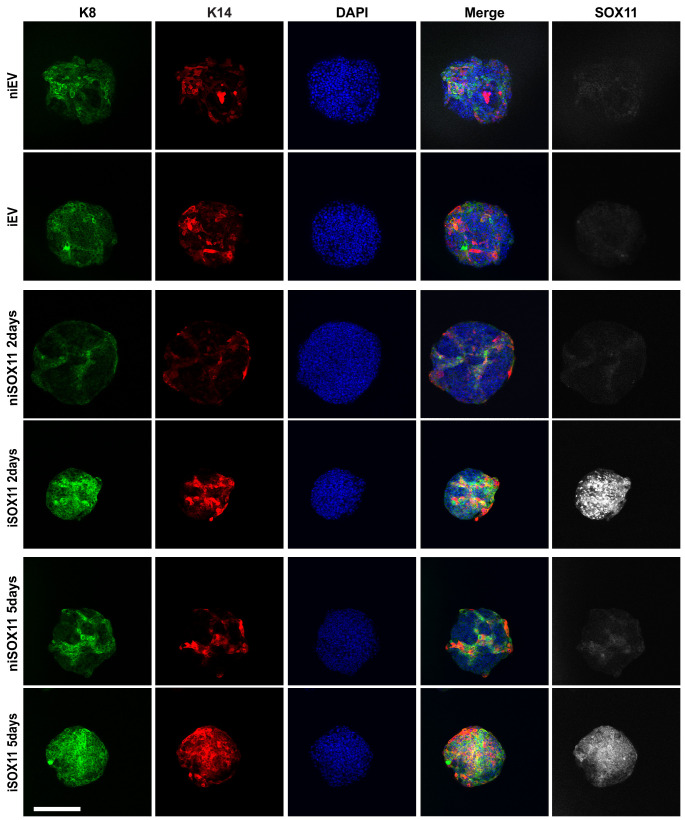
Inducible expression of SOX11 in DCIS.com spheroids leads to changes in epidermal marker expression.Confocal images of spheres formed with niEV, niSOX11, iEV and iSOX11 cells induced for 2 or 5 days with 1 μM DOX, and stained by IF with K14, K8 and SOX11. Scale bar: 200 μm. DOX: Doxycycline, IF: Immunofluorescence.